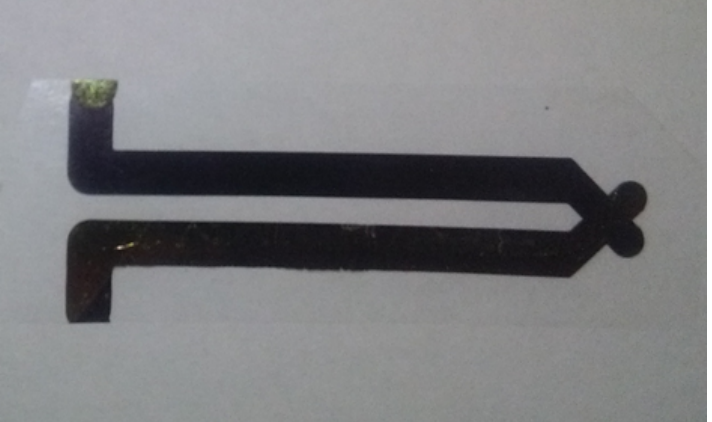
Figure 1. Bauer S 25 PVDF bare shock gauge. Leads are on each side of the tape, sensing area is located at their facing portions.